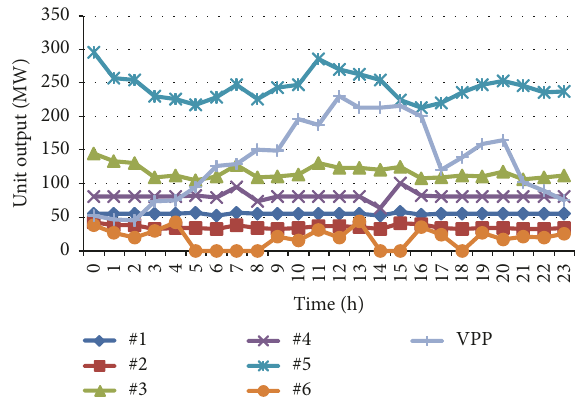
Figure 4: The output curve of each unit in the system. Figure 5: Bidding output variation curve of